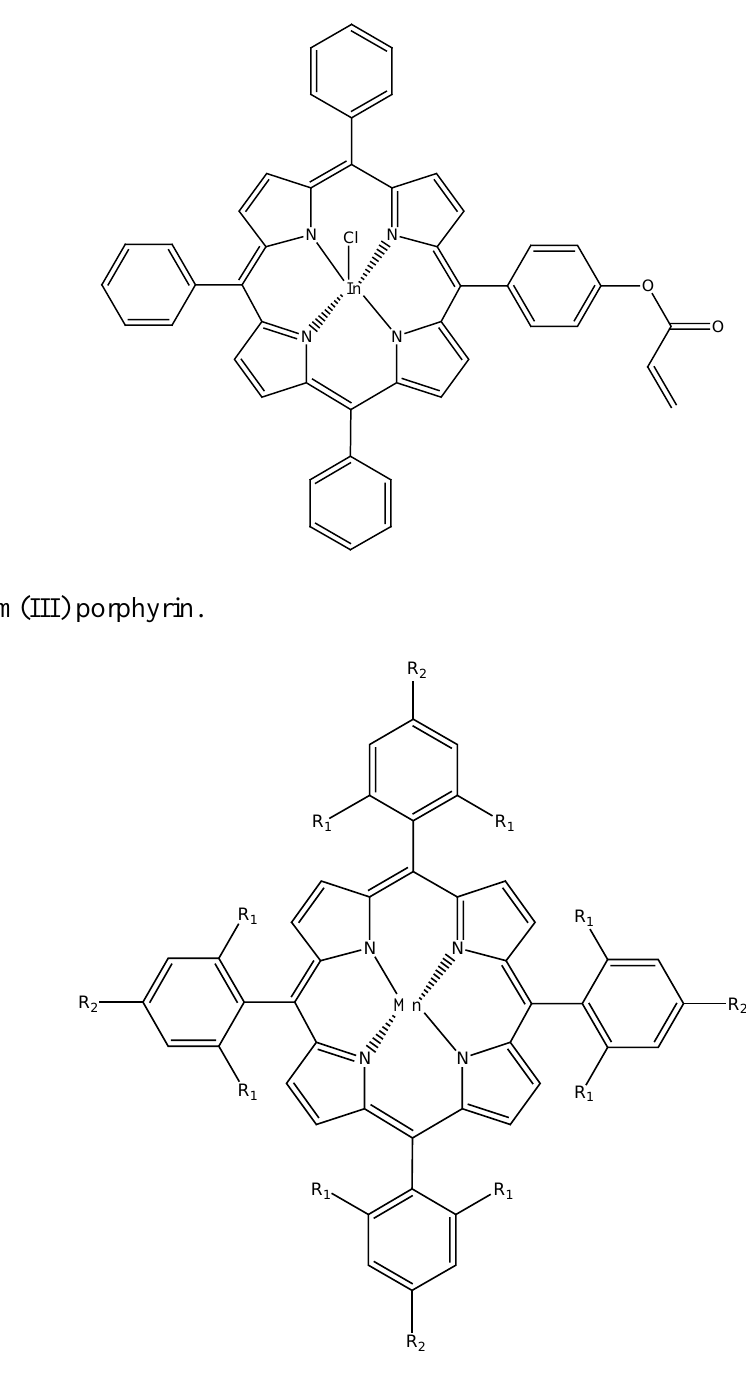
Figure 25. Tetra(trimethylphenyl)porphyrinato Manganese(III)